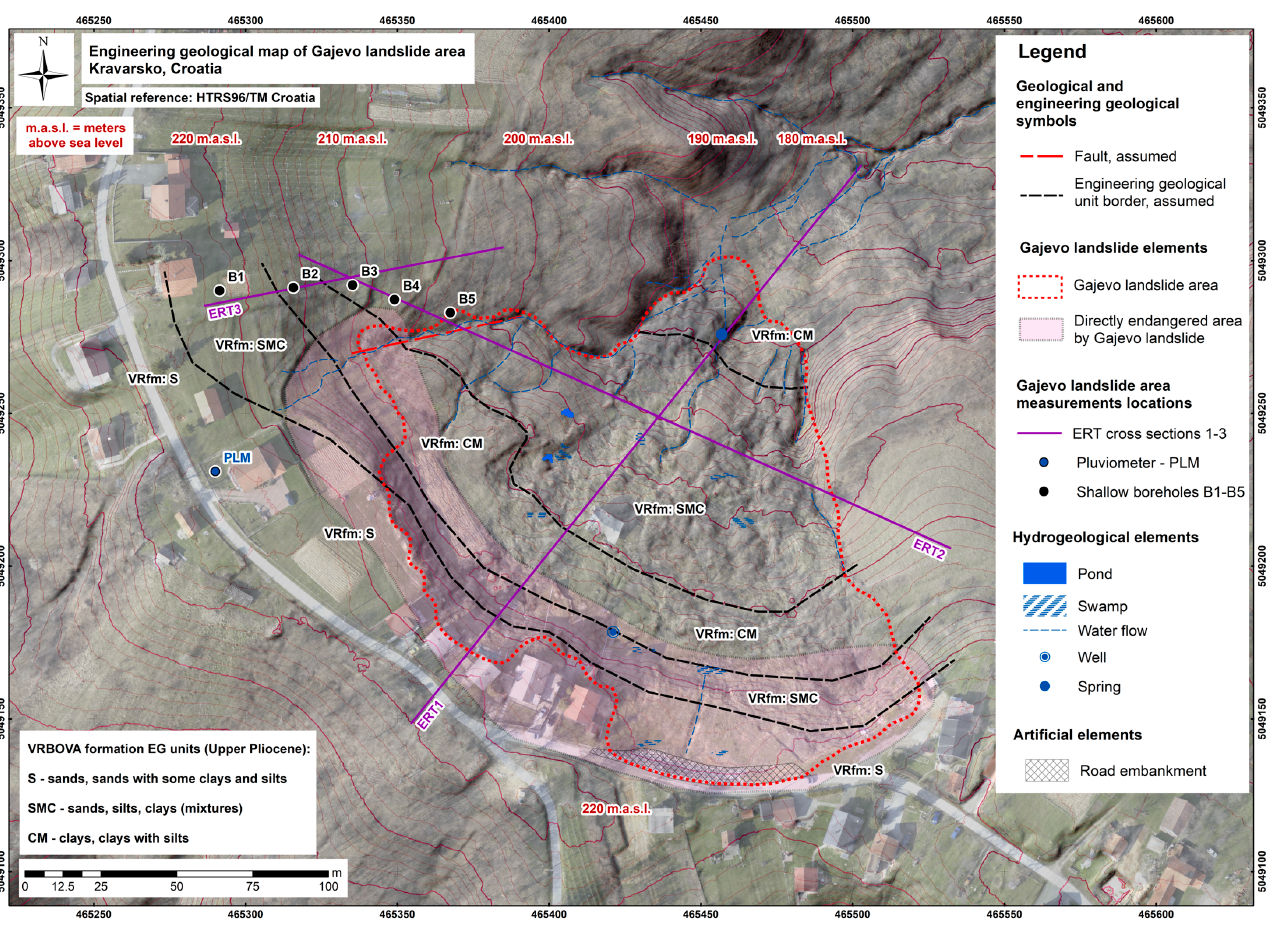
Figure 4. Updated engineering geological map of Gajevo landslide area with high-resolution orthophotos (10 × 10 cm pixel size) and a high-resolution digital elevation model (0.5 × 0.5 m cell size DEM) used as a base map. From the map is visible that five houses “above” the landslide in the vicinity of ERT1 are directly endangered. The ERT1–3 cross-section markings are placed at the cross-sections starting points.